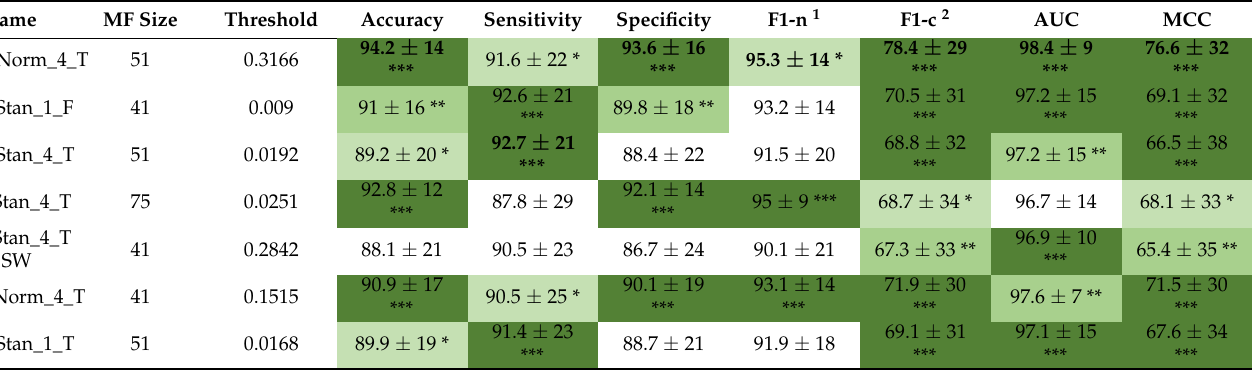
Table 7. Optimal post-processing parameters, metrics after post-processing (both AWP and AP) and statistical differences in comparison with the baseline approach without post-processing. * means p ≤ 0.05, ** means p ≤ 0.01, *** means p ≤ 0.001. The smaller the p , the more intense the green color that was used.